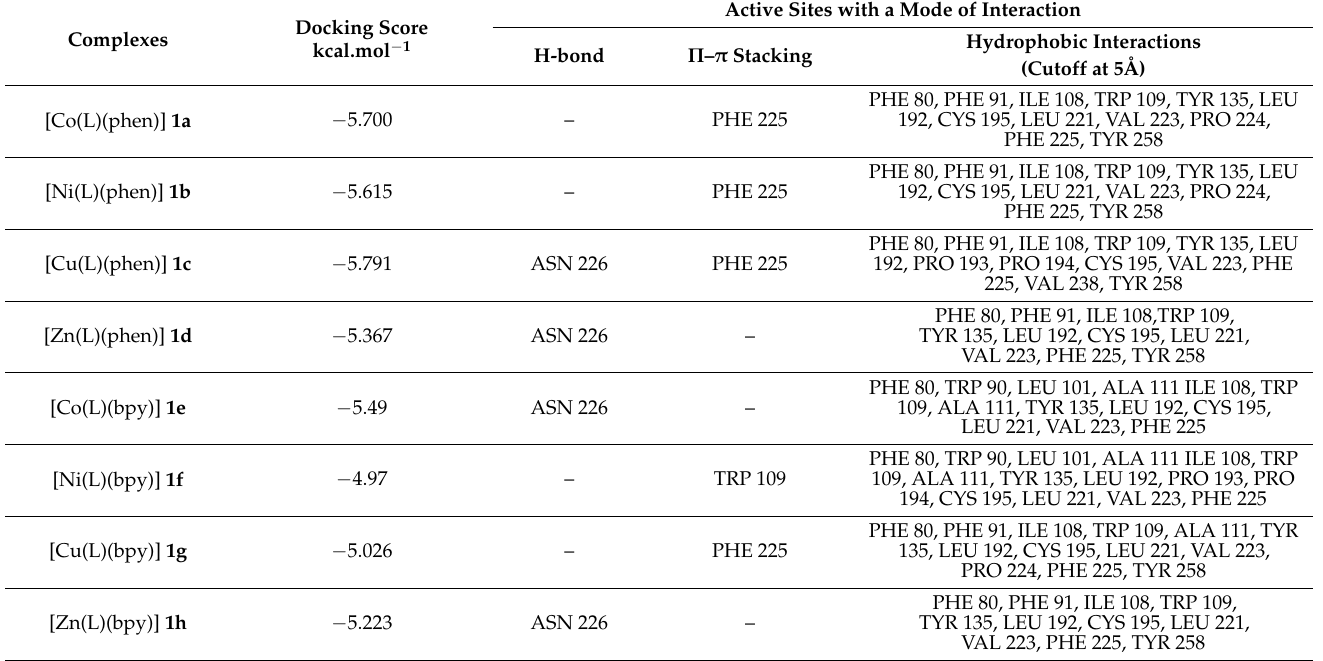
Table 10. Molecular docking parameters of complex 1(a–h) with TS